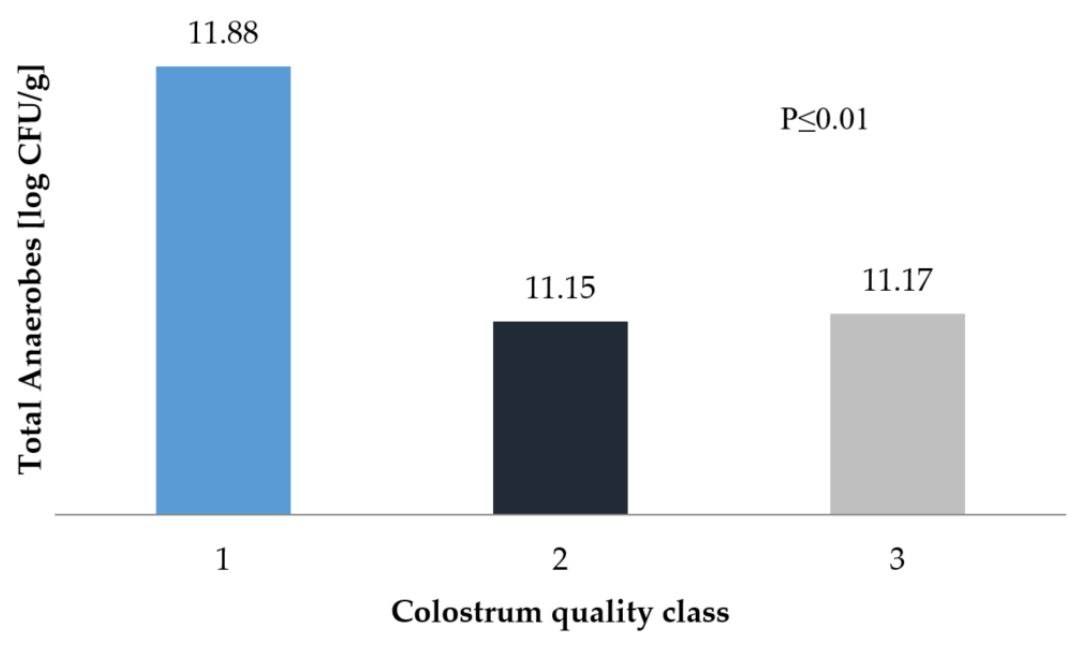
Figure 1. Total anaerobes count in faecal samples depending on the class of colostrum.